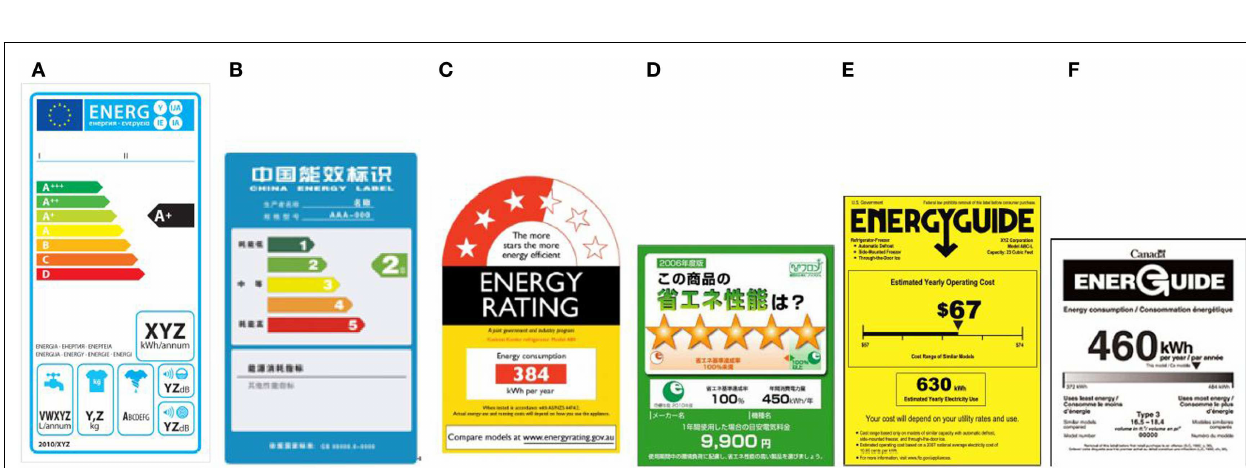
Currently, comparative labels not only differ with respect